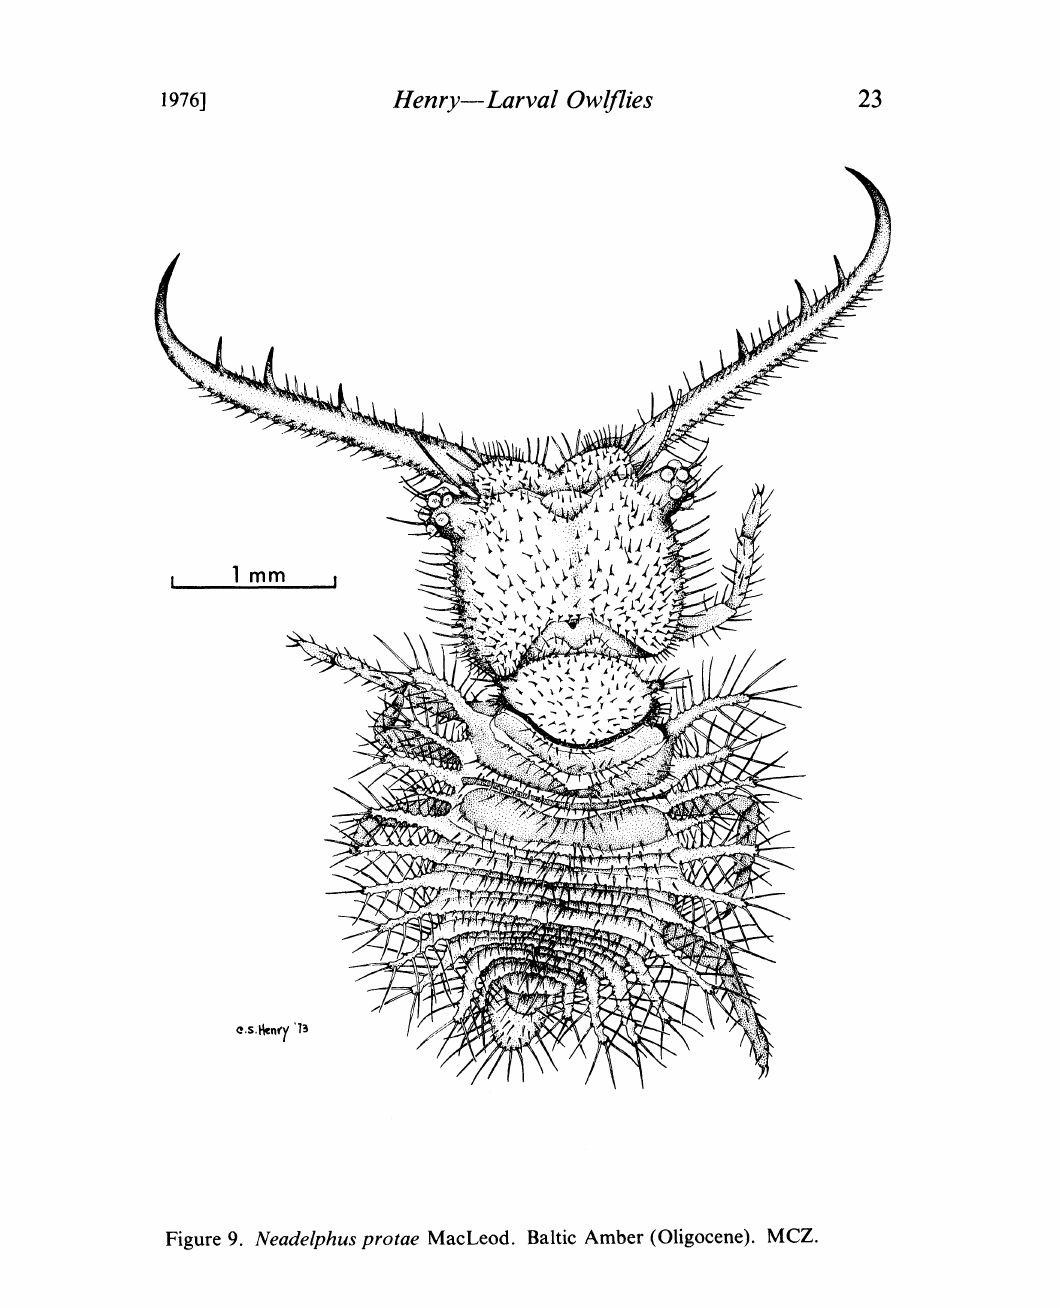
Figure 9. Neadelphus protae MacLeod. Baltic Amber (Oligocene).